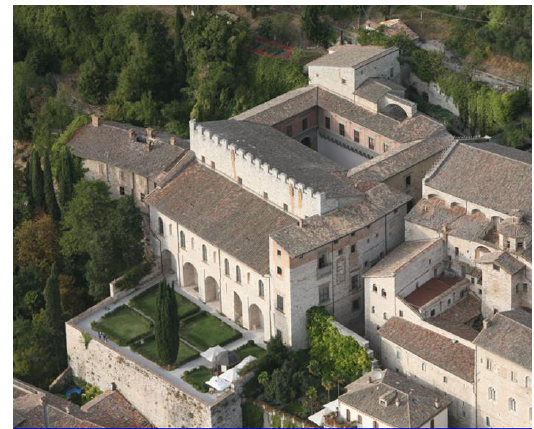
Figure 1 . Aerial view of the Palazzo Ducale